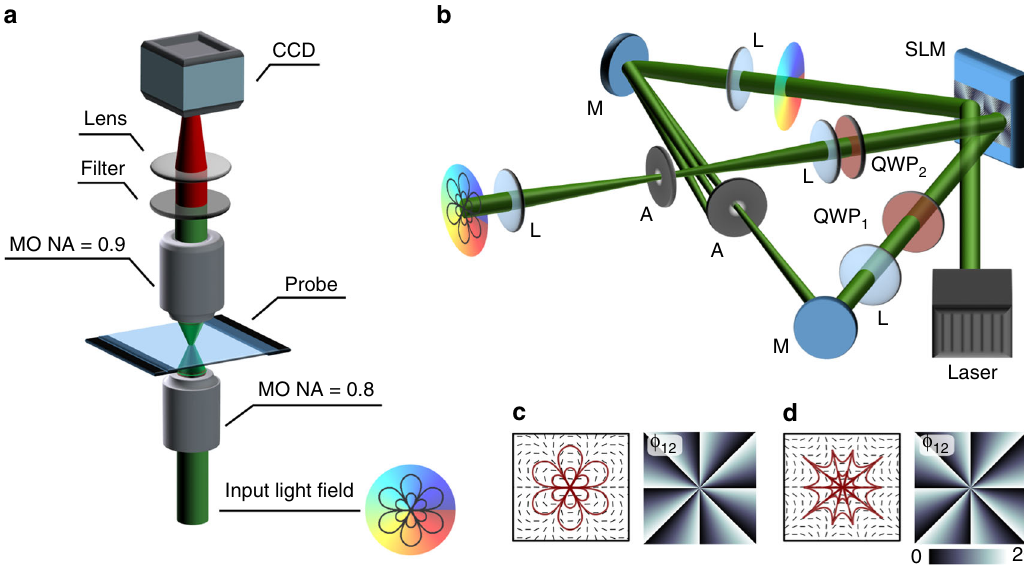
Fig. 1 Concept of detecting non-paraxial light fi elds. a Microscope system for tightly focusing tailored paraxial light fi elds and detecting fl uorescence; b setup for the generation of tailored vectorial light fi elds with additional phase vortices (paraxial regime; SLM: spatial light modulator, L: lens, M: mirror, A: aperture, QWP 1,2 : quarter wave plate, CCD camera); c vectorial fl ower and d spider web structure ( σ 12 = ±8), whose polarization distribution is indicated black lines (red: fl ow lines), with according phase Φ 12 of complex Stokes fi eld Σ